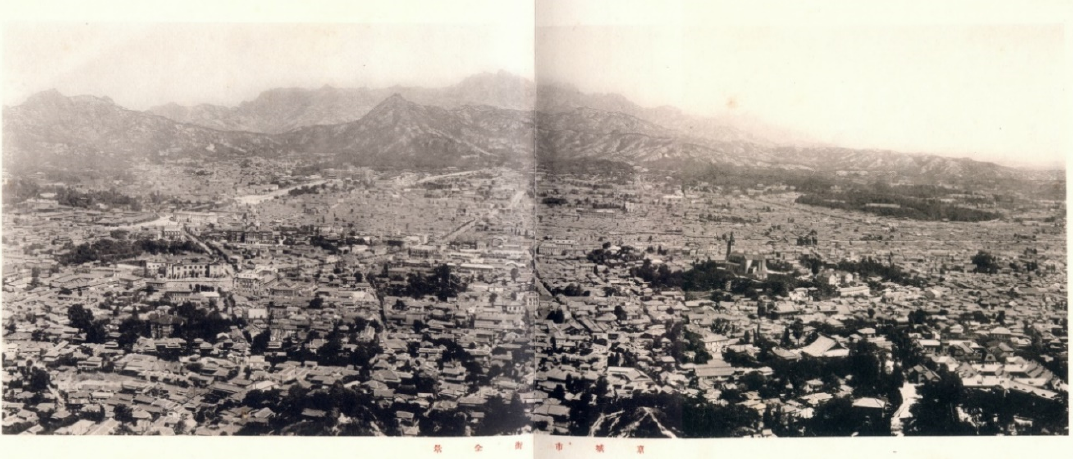
Figure 1. View of Seoul circa 1921. Sŏ 27618. After Chōsen Sōtokufu (1921). Courtesy of Seoul Mu- seum of